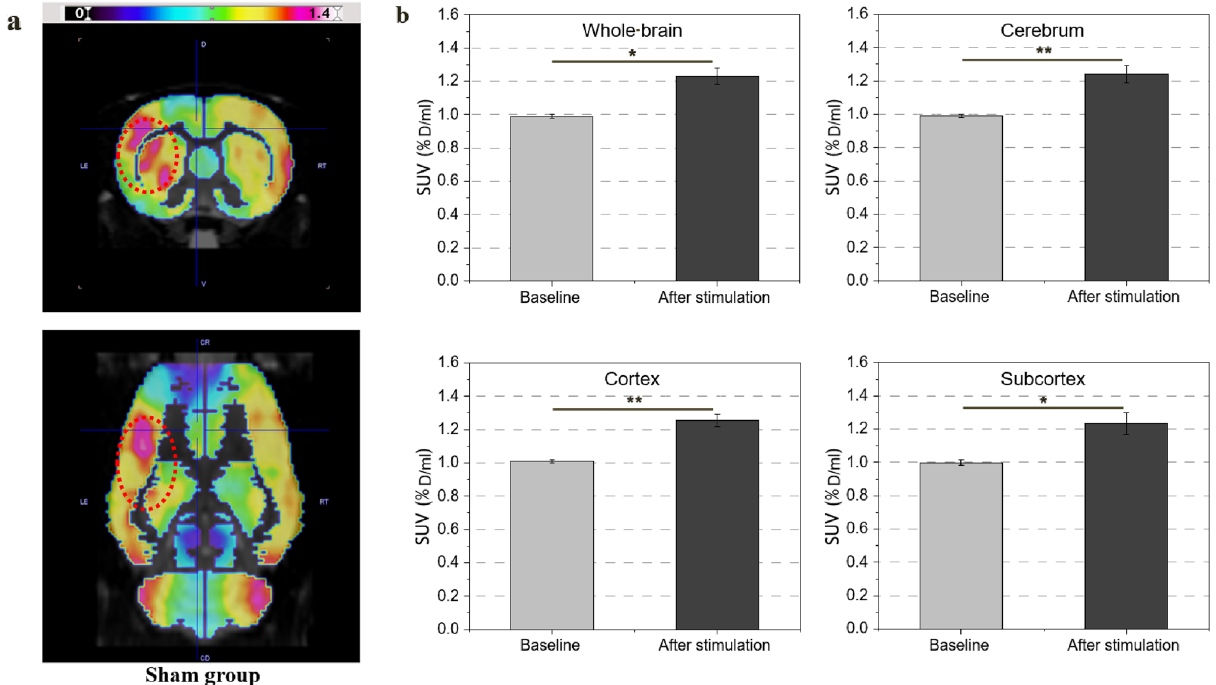
Figure 9. Changes in SUV index in the sham group (n = 9). ( a ) PET/CT images of brain activation before and after heating in the sham group. ( b ) SUV index at baseline and after heating in the cerebrum, cortex, and subcortex, and whole-brain average (p < 0.05). Increased metabolic activation of 24% was observed even in the same brain site without